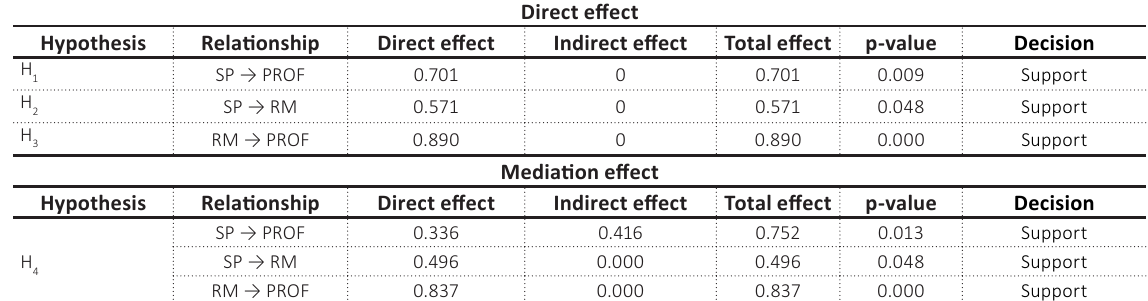
Source: Author’s